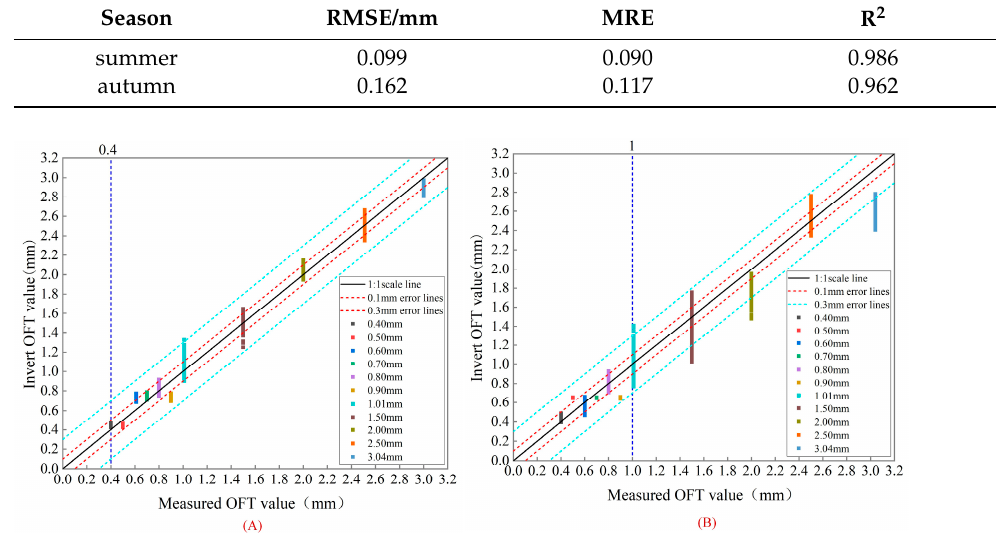
Figure 14. Comparison of measured OFT and inverted OFT: ( A ) summer, OFT ≥ 0.4 mm; ( B ) autumn, OFT ≥ 0.4 mm. Table 3. Evaluation of inversion accuracy.